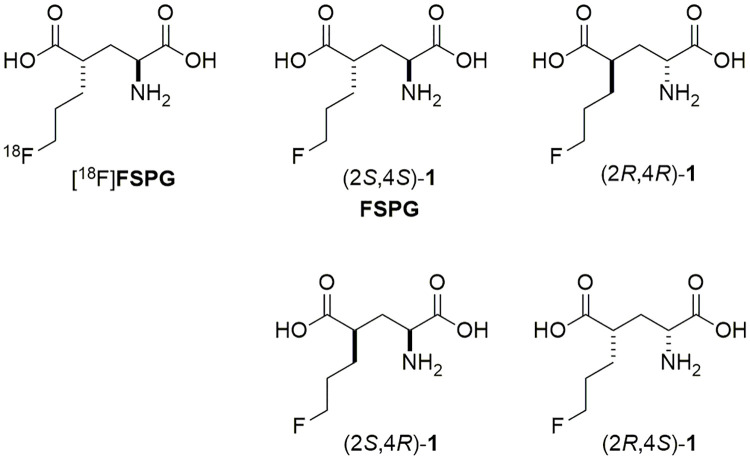
The structures of nonradioactive FSPG stereoisomers and [18F]FSPG.